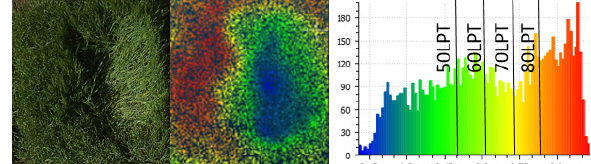
Figure 10. RGB imagery of barley plot showing intensity of lodging (left) and corresponding lodging severity derived from the CHM (middle), as well as canopy height distributions (m) with visualization of different lodging percentage thresholds (LPTs) (right).